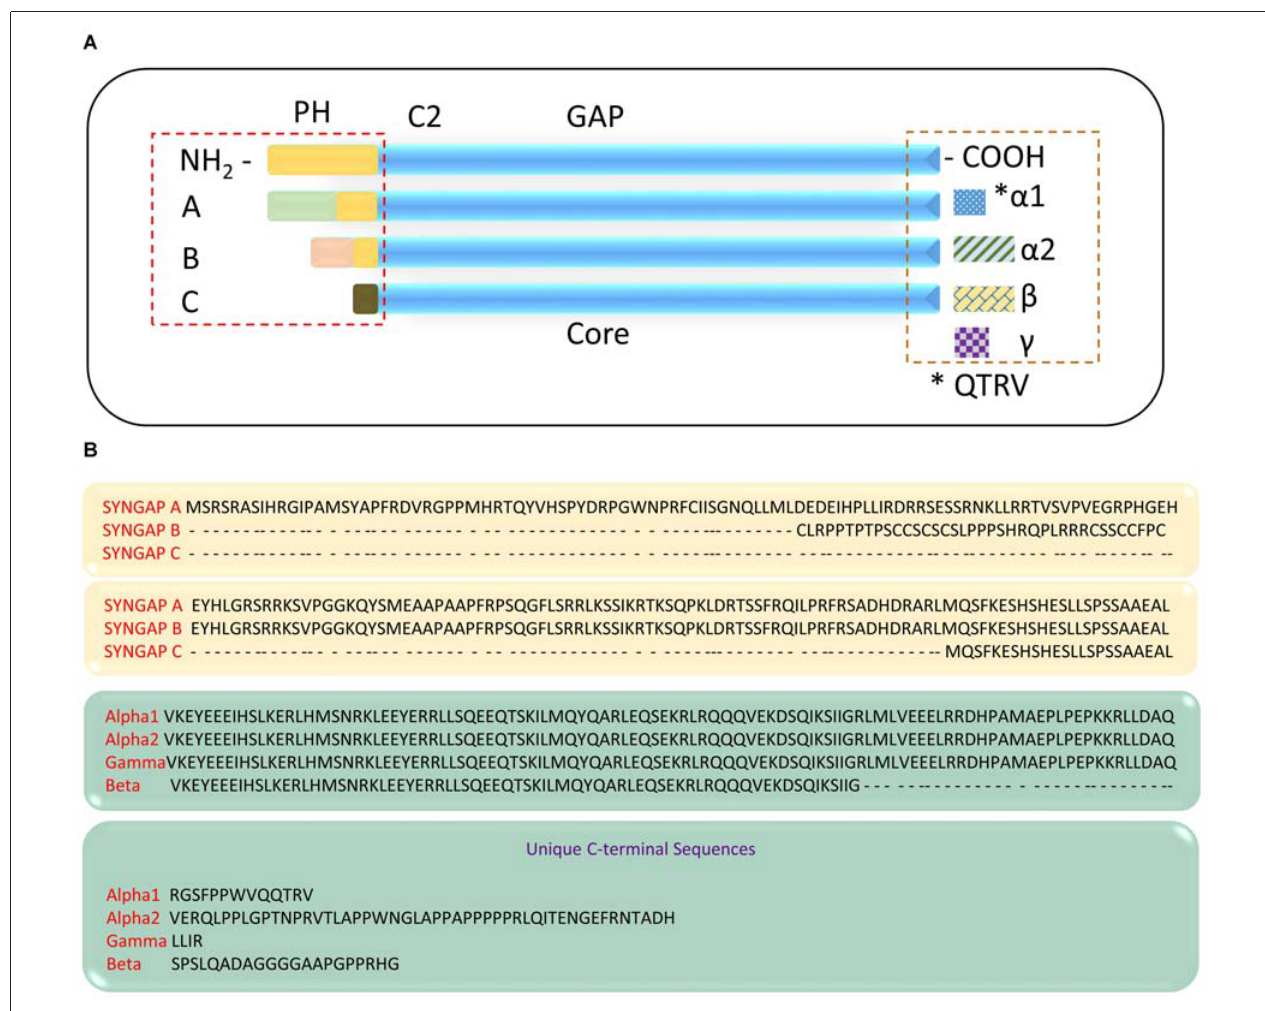
FIGURE 2 | SYNGAP1 isoforms arising from alternate splicing. (A) A schematic illustration of potential SYNGAP1 isoforms, which vary in both N- and C-termini. (B) Amino acid sequences that are unique to different N- and C-termini isoforms identified by mass spectrometry (McMahon et al.,